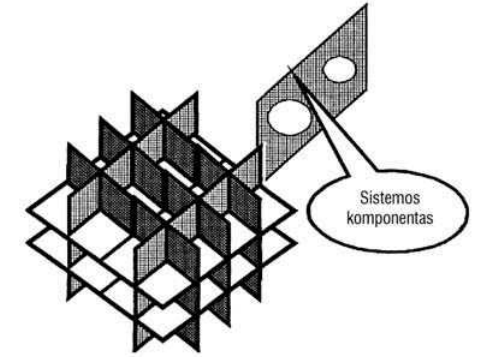
(posistemius, dalis, elementus), jų tarpusavio ryšius ir santykius Fig 4. System is a complicated totality including its components, their interconnections and relationship